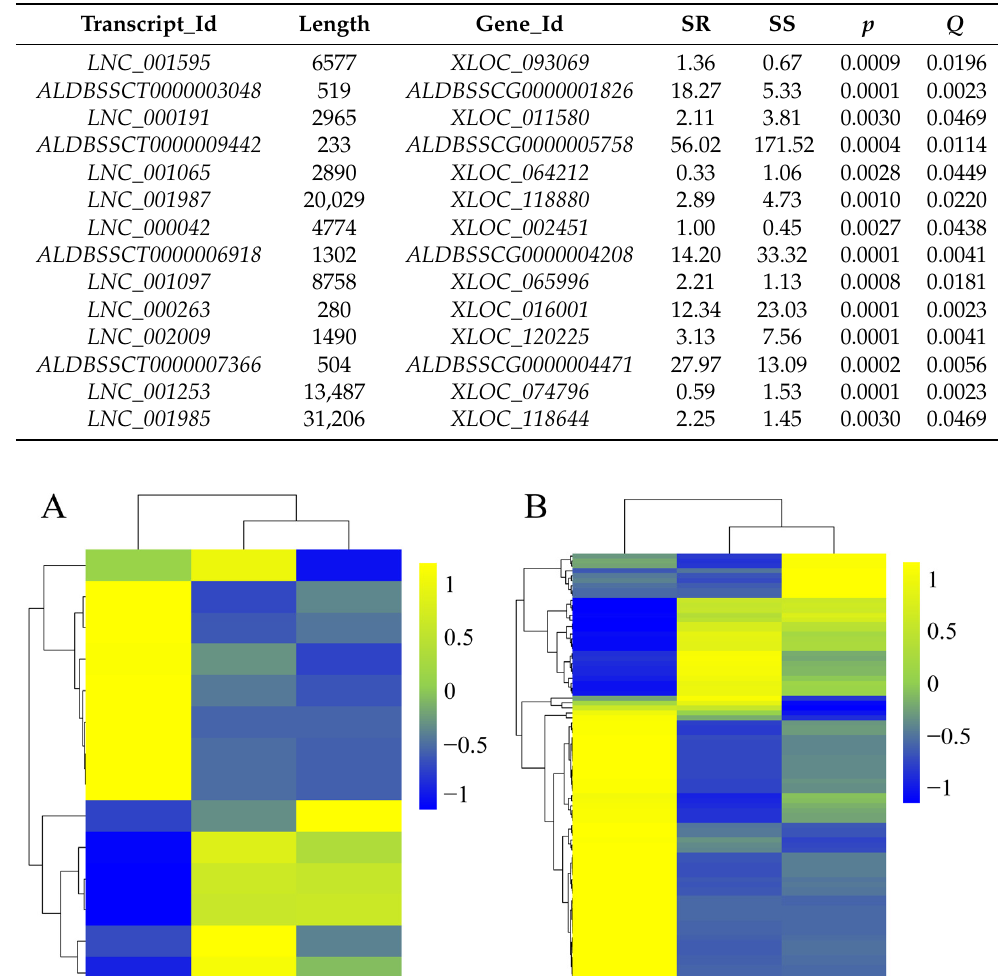
Table 1. Detailed information of 14 DE lncRNAs between SR and SS groups compared to SC group.